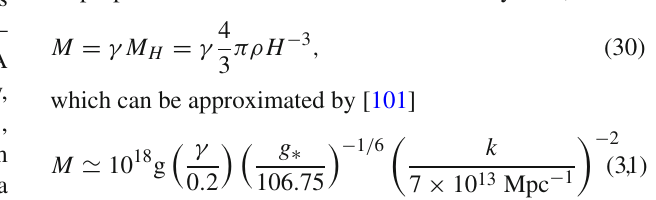
Fig. 4 Primordial power spectrum of scalar perturbations predicted by ModelIforparameterset(20)(leftpanel),andbyModelIIforparameter set (23) (right panel). Also we show the upper bound from μ -distortion